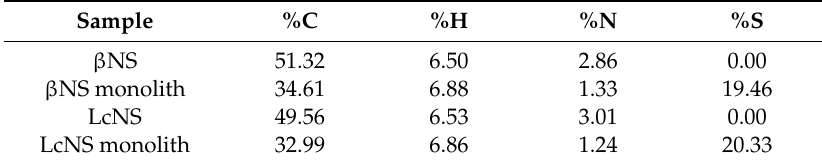
Table 3. CHNS of the β NS and LcNS, ground and purified, and β NS and LcNS monoliths without purification.